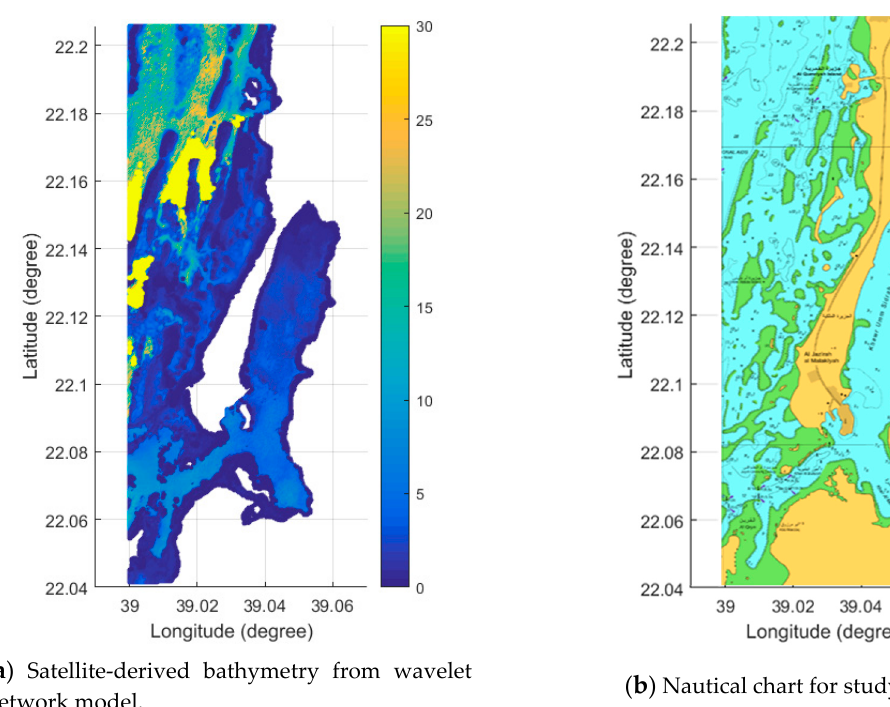
Figure 12. The difference between the Stumpf log-ratio model estimates, the ANN model estimates, and the wavelet network model estimates, when compared with “truth” nautical chart depths for the 90 collocated stations.